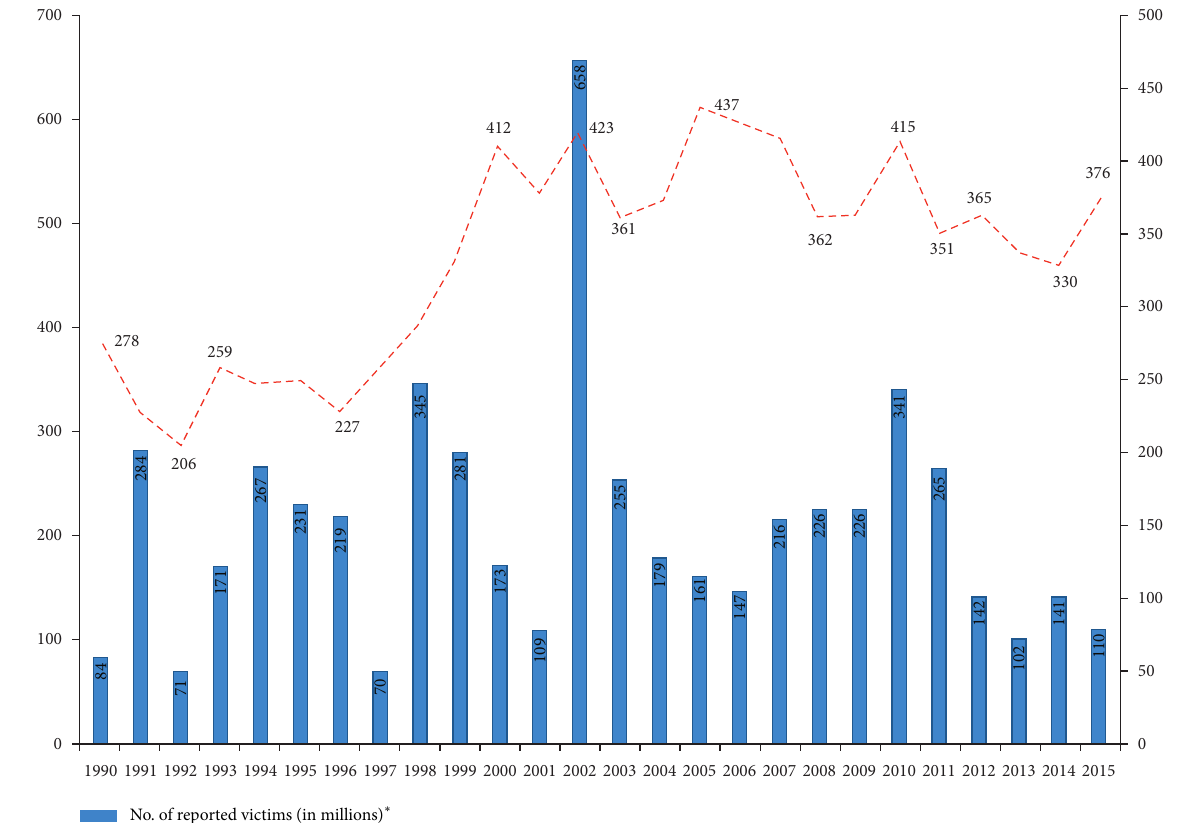
Figure 1: Trends in occurrence and victims of disasters